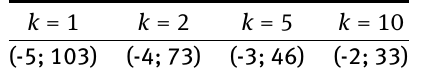
Table 4.5: TVaR bounds for d = 50 , α =